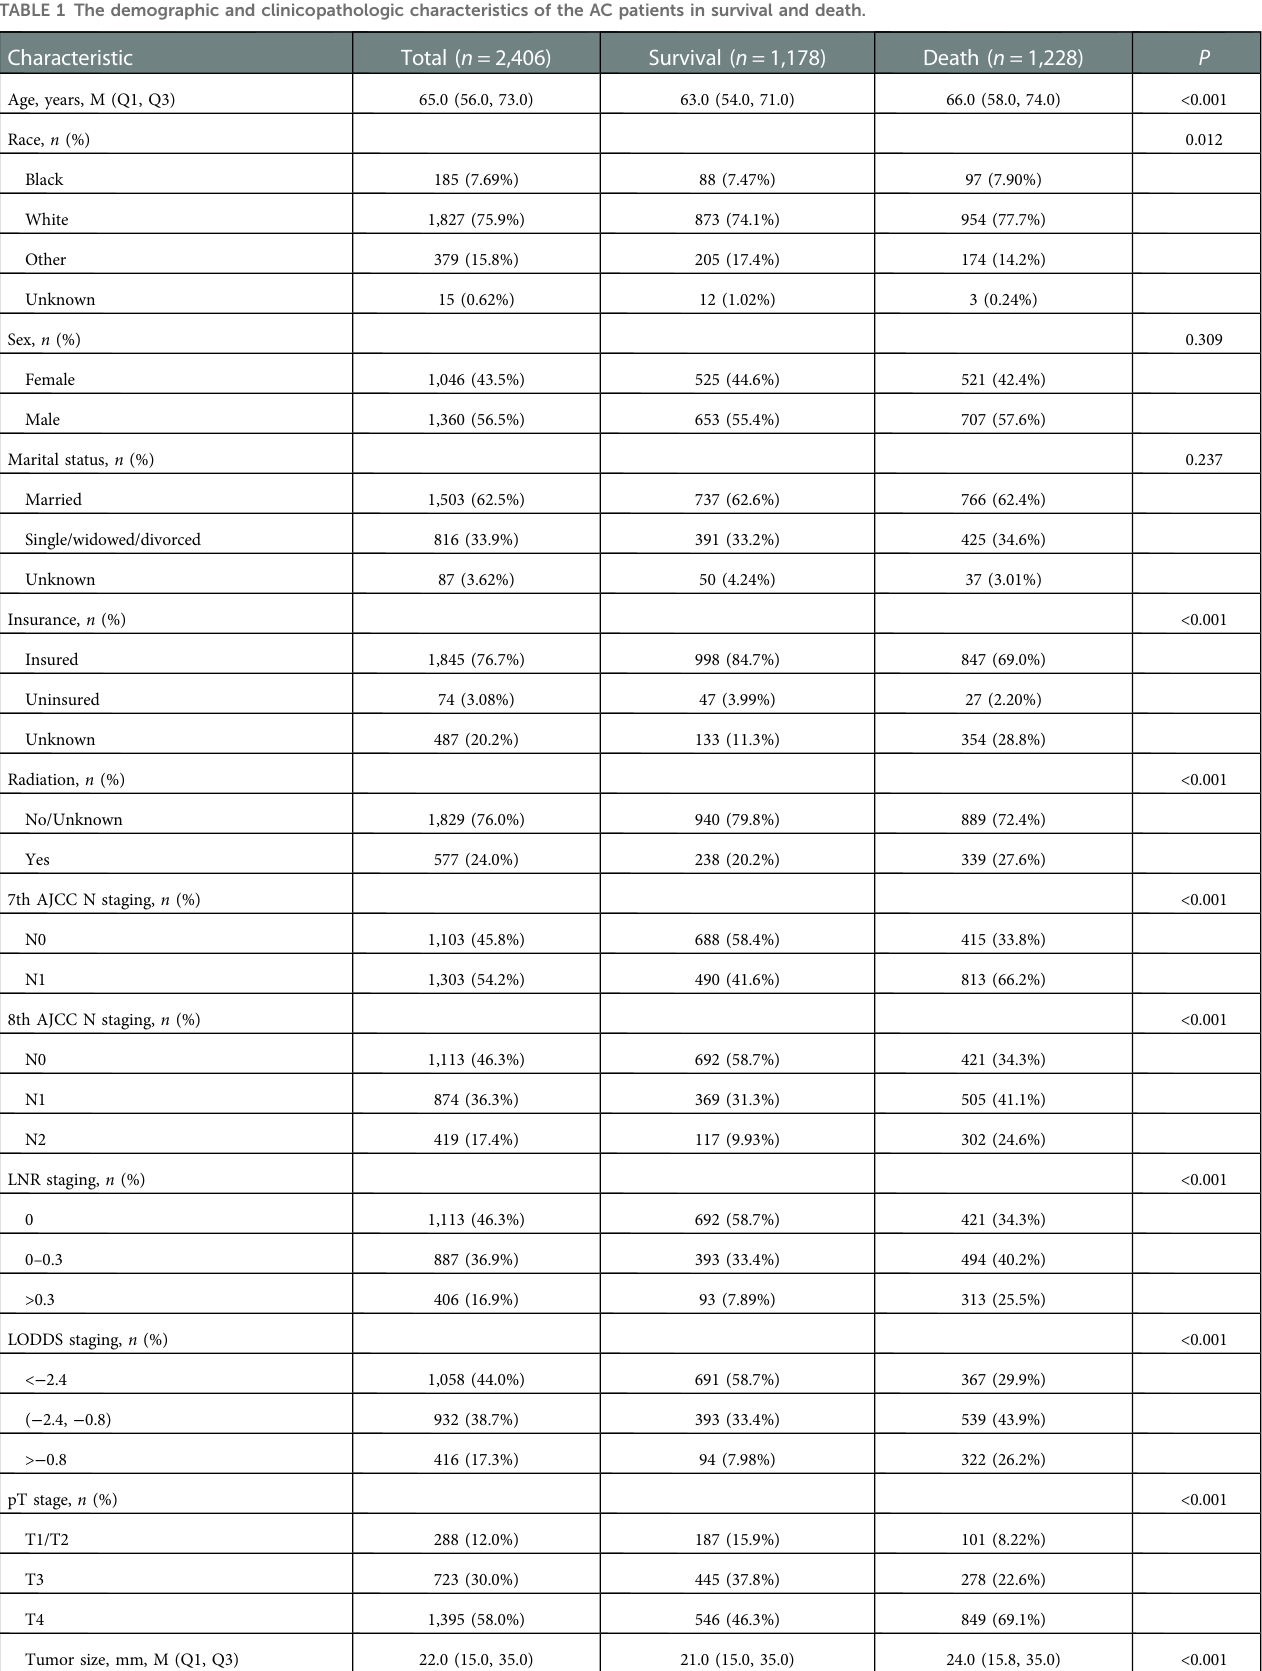
TABLE 1 The demographic and clinicopathologic characteristics of the AC patients in survival and